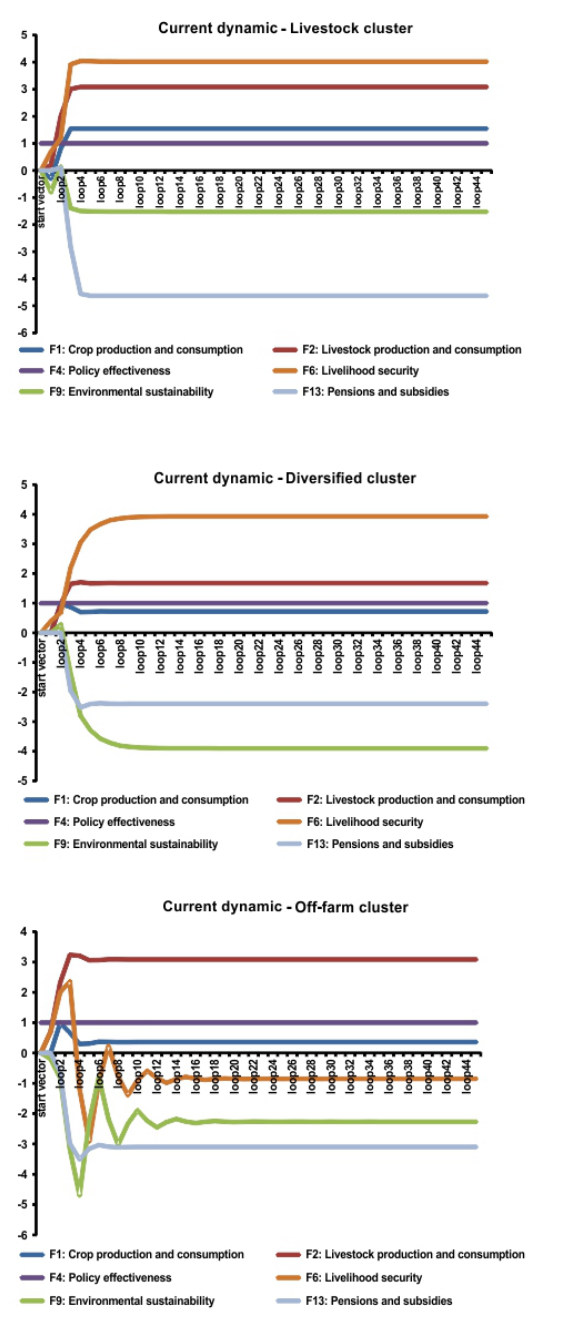
Fig. 7 . Outputs of the three fuzzy cognitive maps. X-axis: number of iteration steps. After stabilization, each line indicates the current dynamic situation of each factor, according to the small farmers’ current perceptions; Y-axis: value of factors. The values indicate whether the small farmers perceived positively or negatively each factor. Higher values indicate the importance of the